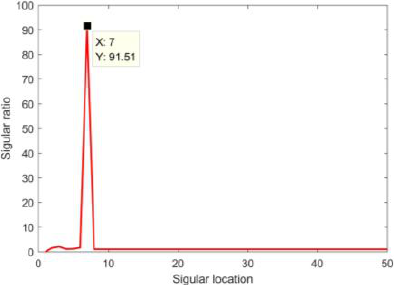
Figure 7. The singular ratio distribution.